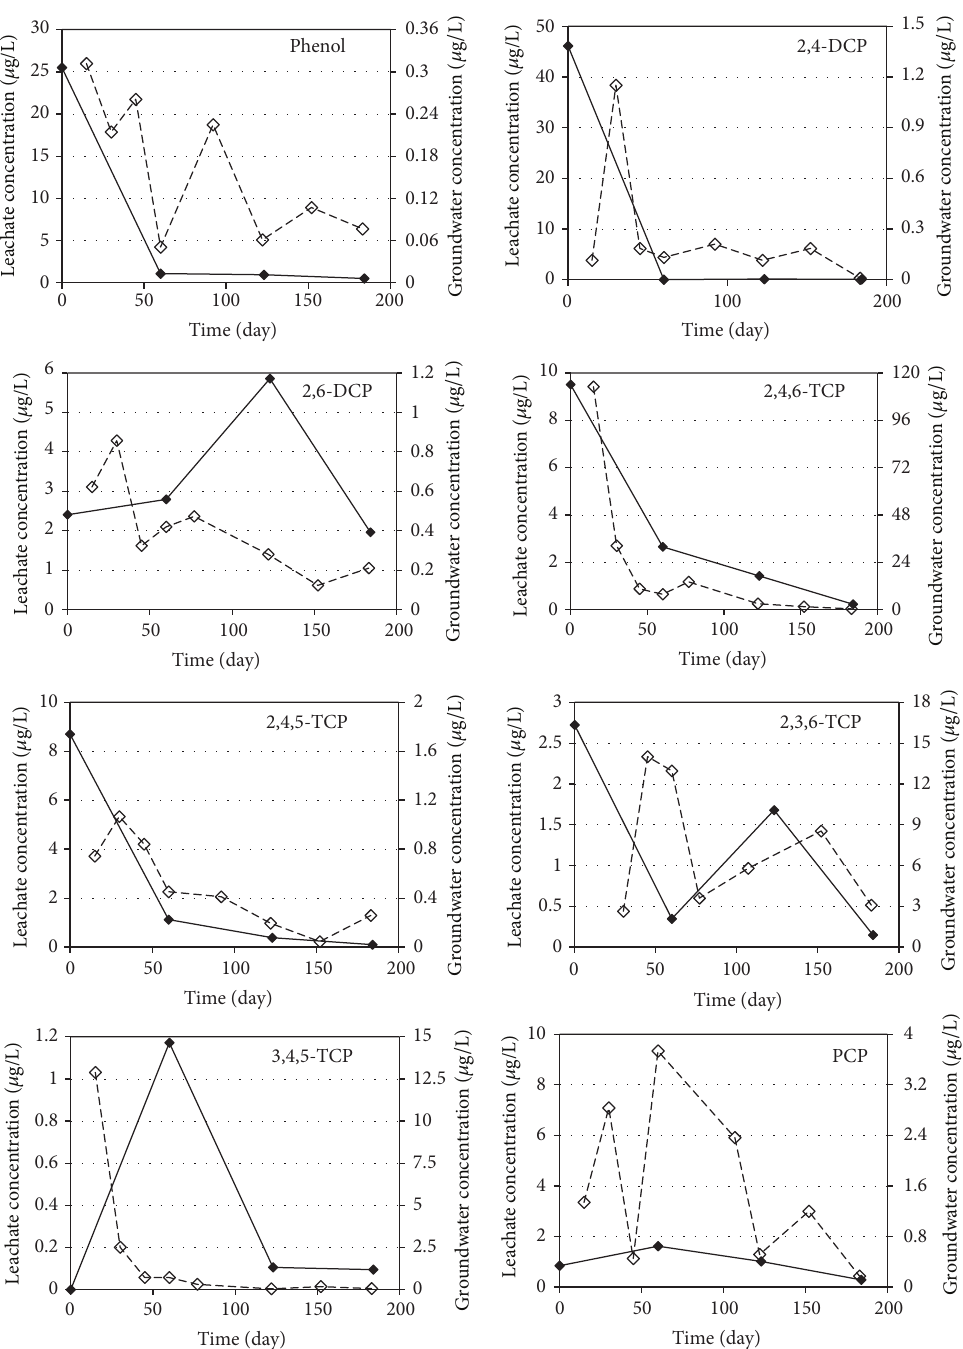
Figure 3: Variations of the phenolic compounds in groundwater and leachate samples of R2 reactor (——: leachate concentration, -----: groundwater